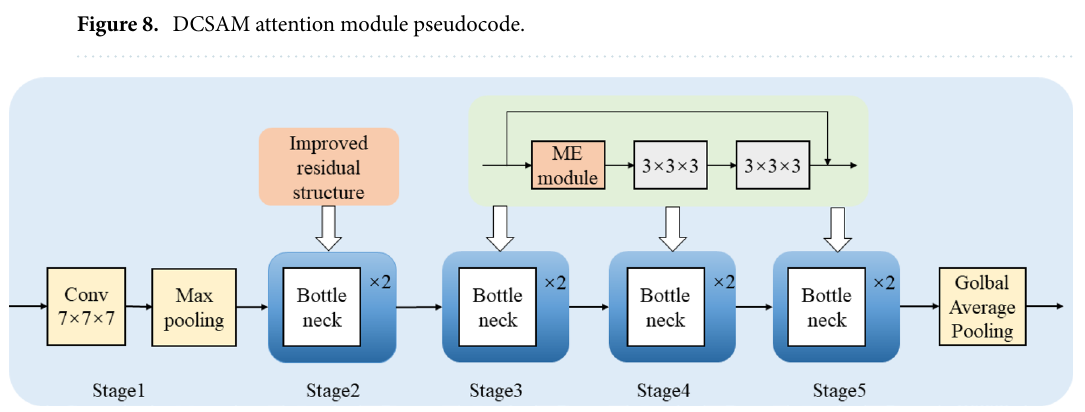
Figure 9. Improved 3D-ResNet18 network